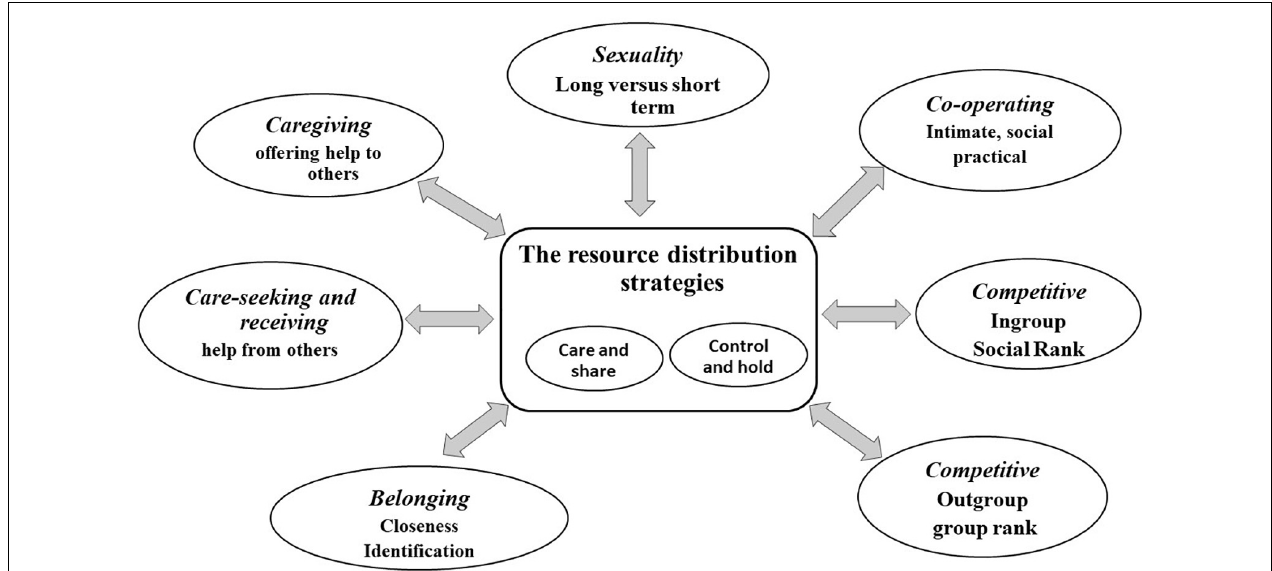
FIGURE 4 | Resource distribution strategies in social